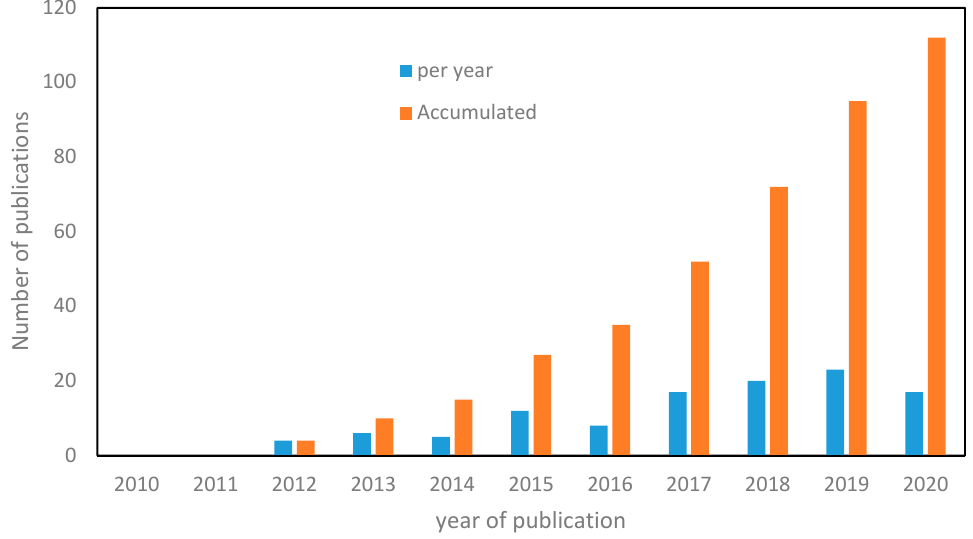
Figure 2. Yearly and accumulated numbers of publication on forward osmosis for concentration (database: Scopus, search parameters: “forward osmosis concentration” in title, abstract and keywords and after removing results from “forward osmosis concentration polarization”.